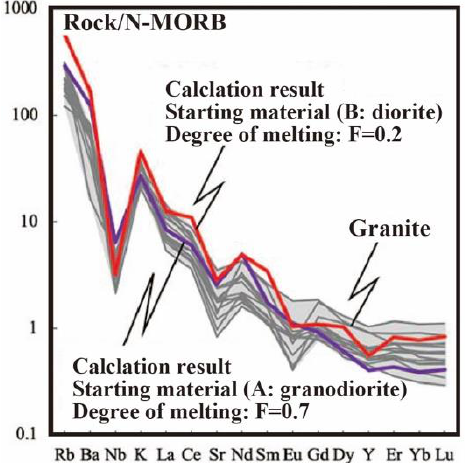
Figure 12. Spider diagram normalized to the primitive mantle [14] plotting the compositional ranges of the granite (gray field) and calculated granite magma (red and purple lines). The inferred granite magmas are plotted within the compositional field of granite. The granite magma can be produced by the partial melting of Ryoke plutonic rocks. See the text for further discussion.